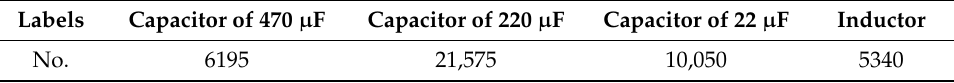
Table 2. The numbers of di ff erent